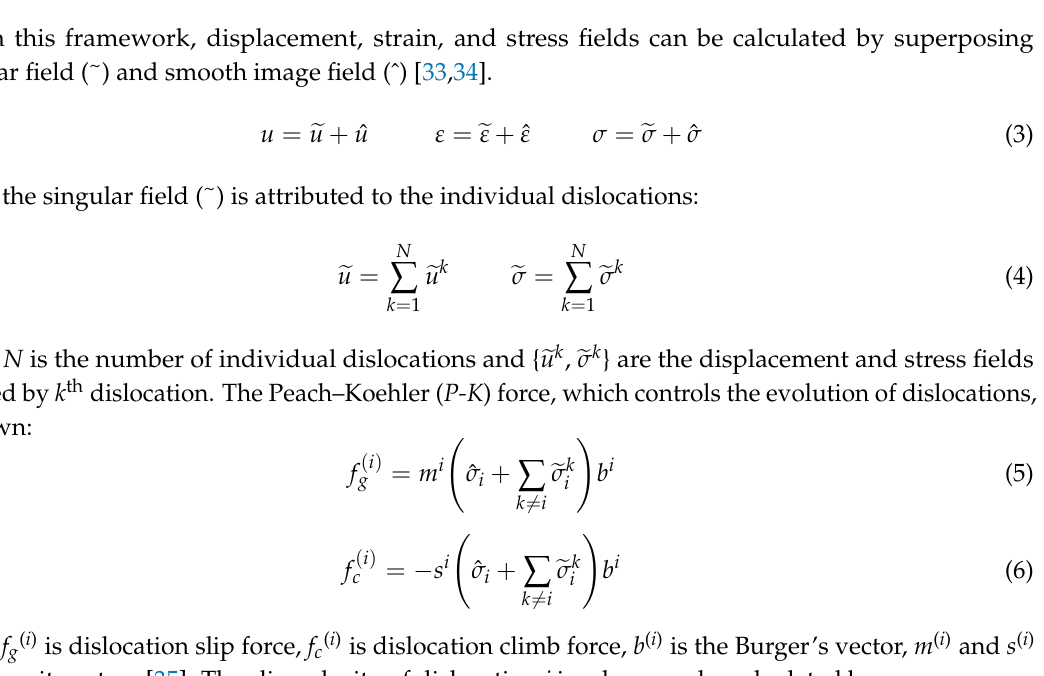
Figure 6. Multiscale discrete dislocation plasticity framework model.